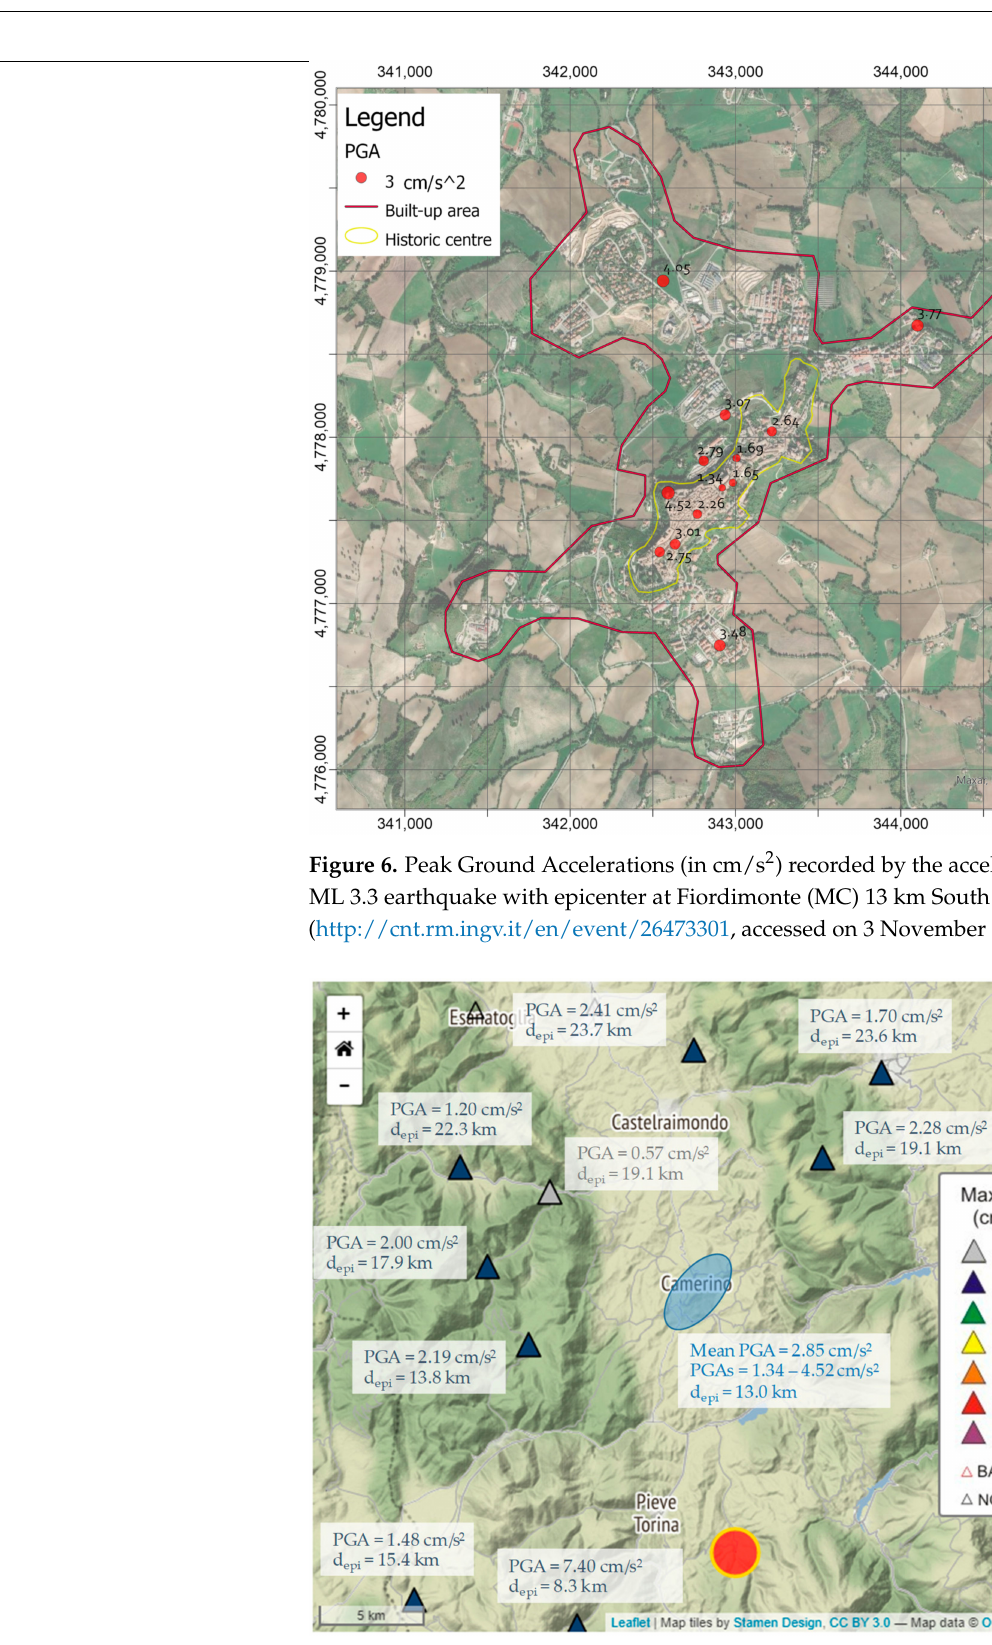
Figure 7. Peak Ground Accelerations (PGAs in cm/s 2 ) were recorded by the Italian seismic network around Camerino during the ML 3.3 earthquake with epicenter at Fiordimonte (MC) on 18 April 2021 (after http://ismd.mi.ingv.it/evento.php?var1=26473301&path=210418172559&rev=auto, accessed on 3 November 2021). PGAs obtained in the Camerino urban area are also